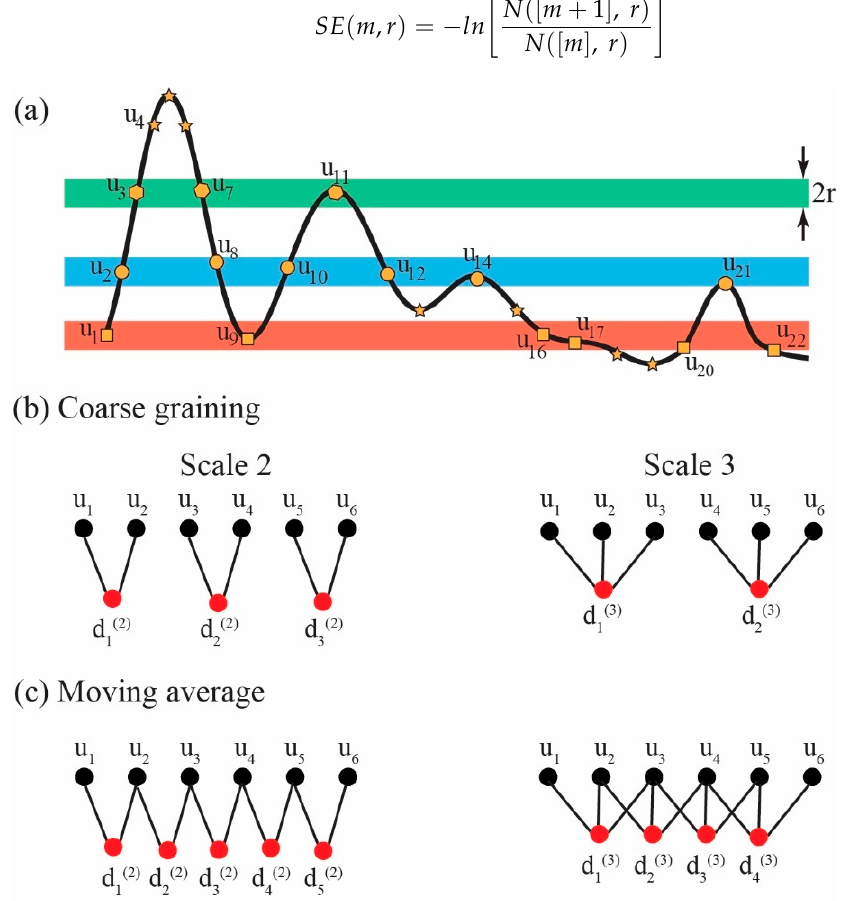
Figure 2. Illustration of sample entropy measurement. ( a ) A synthetic SKS waveform example with time points u 1 , u 2 , u 3 , . . . , u 22 is shown. The horizontal bars indicate the tolerance threshold ( r ) around samples u 1 , u 2 , and u 3 . Square, circle, and hexagonal shapes represent the points within a tolerance level of u 1 , u 2 , u 3 , respectively. Star shapes represent the points that are not within the tolerance level of u 1 , u 2 , or u 3 . Signals can be analyzed at different scales by either ( b ) coarse-graining or ( c ) moving average. Examples are shown for scales 2 (left column) and 3 (right